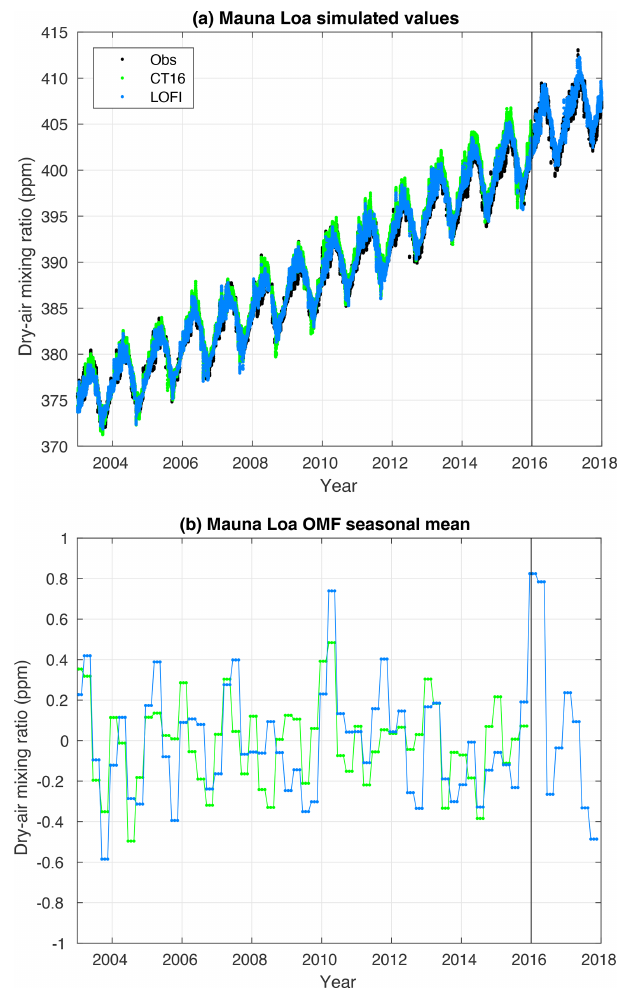
Figure 5. Time series comparisons of model simulations using CT2016 fluxes (green) and using LoFI fluxes (blue) to observations (black) at the Mauna Loa observatory. Panel (a) depicts all samples, while panel (b) is a 3-month mean of the observation minus model differences. The solid black line at 2016 indicates the switch from retrospective to NRT modes in the LoFI